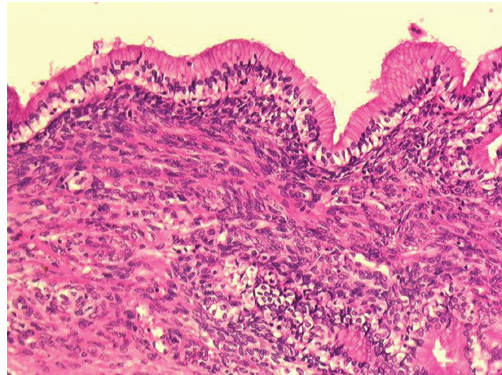
Figure 2: Axial T2 hyperintense cyst with a one-centimeter tissular lesion behind the caudal portion of the cyst (arrow).